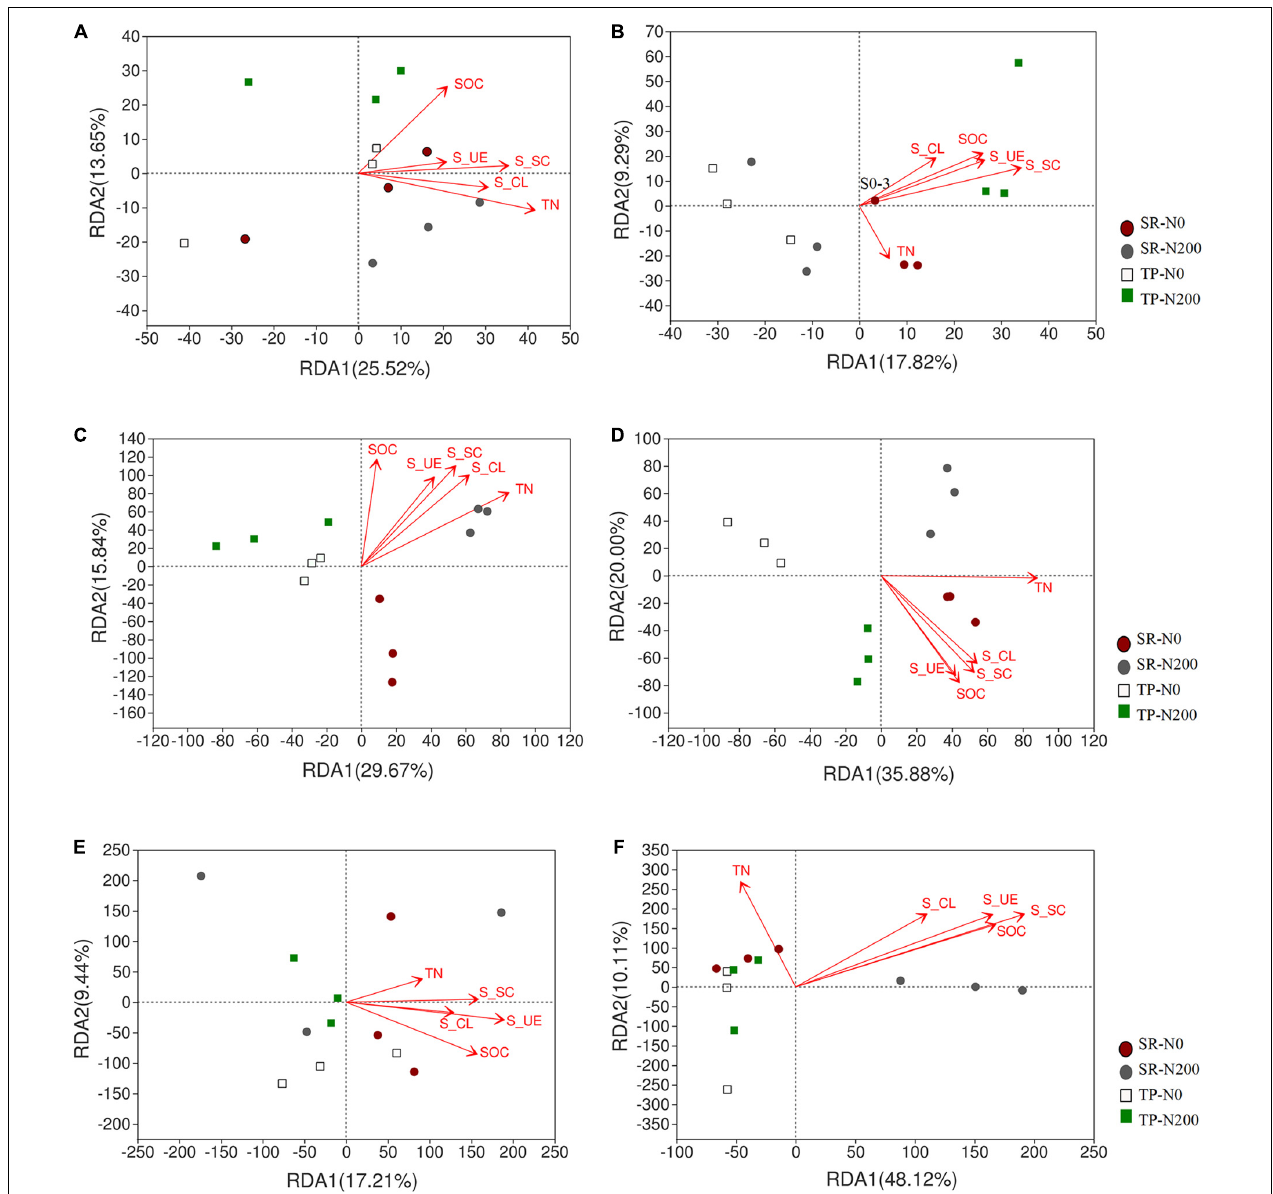
FIGURE 6 | The redundancy analysis (RDA) to identify the relationship of bacterial fungal and nematode OTUs taxa and soil properties. Bacterial in spring (A) and autumn (B) , fungal in spring (C) and autumn (D) , and nematode in spring (E) and autumn (F) seasons. S0 = straw returning without nitrogen fertilizer application; S200 = straw returning with 200 kg/ha nitrogen fertilizer application; T0 = traditional planting without nitrogen fertilizer application; T200 = traditional planting with 200 kg/ha nitrogen fertilizer application.